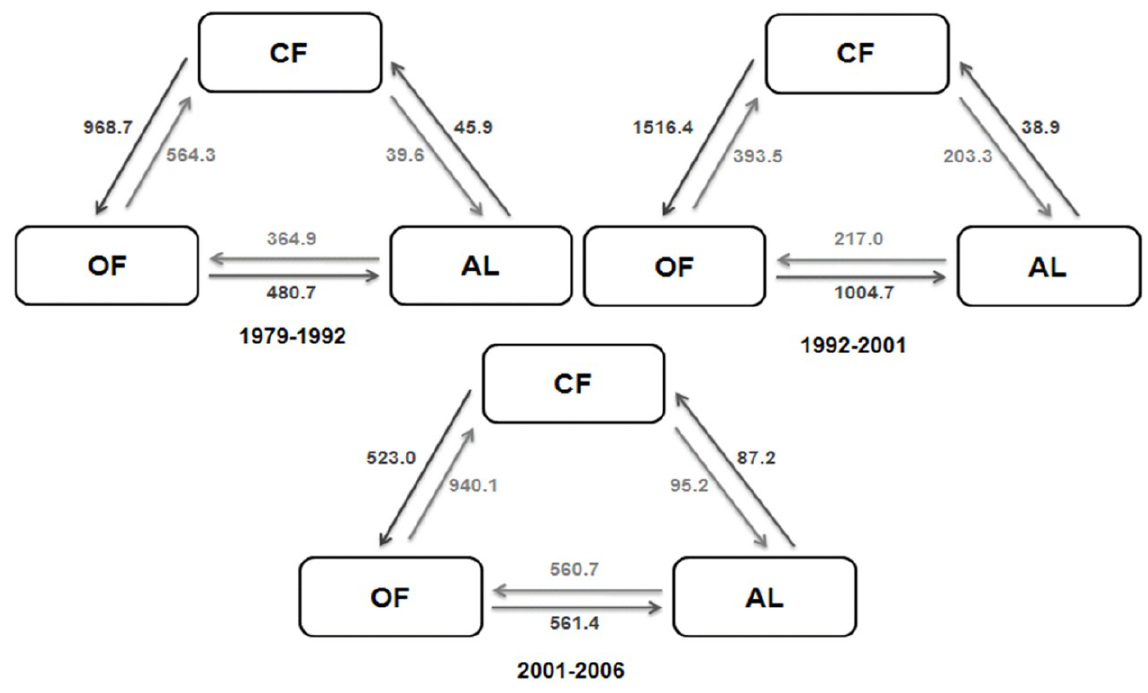
Figure 4 Land-cover change dynamic during 1979 and 2006, the unit is ha; CF: closed canopy forest; OF: open canopy forest; AL: agricultural